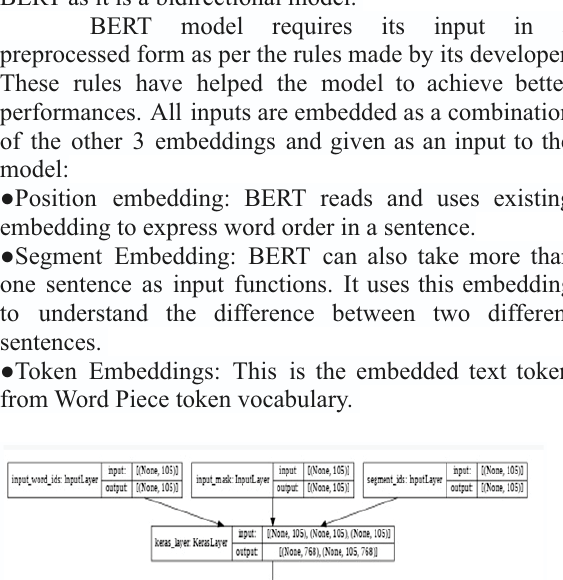
Fig.4. Classification report